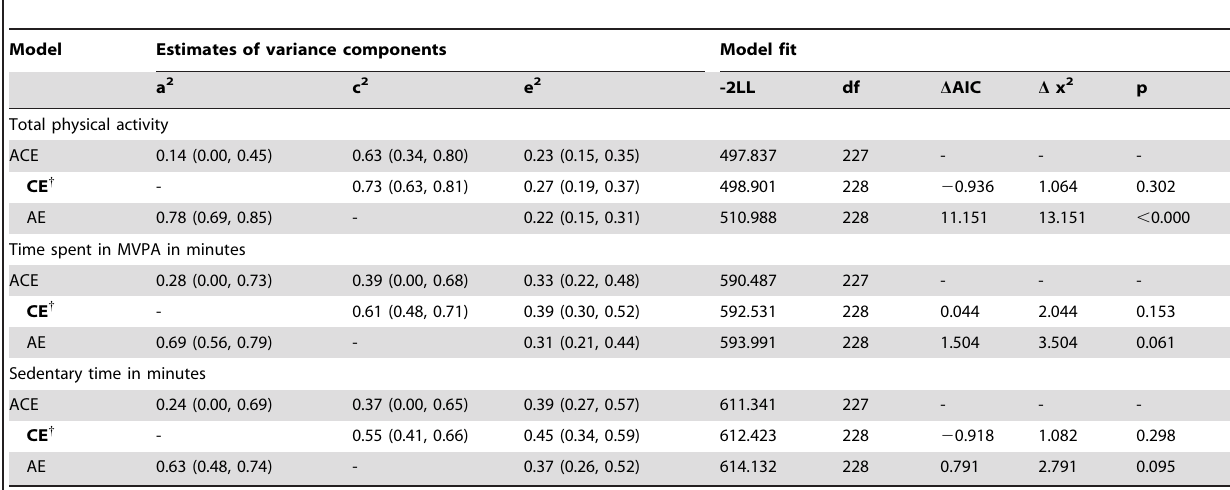
Table 4. Genetic and environmental influences on objectively measured habitual physical activity in 9-12 year old twins.